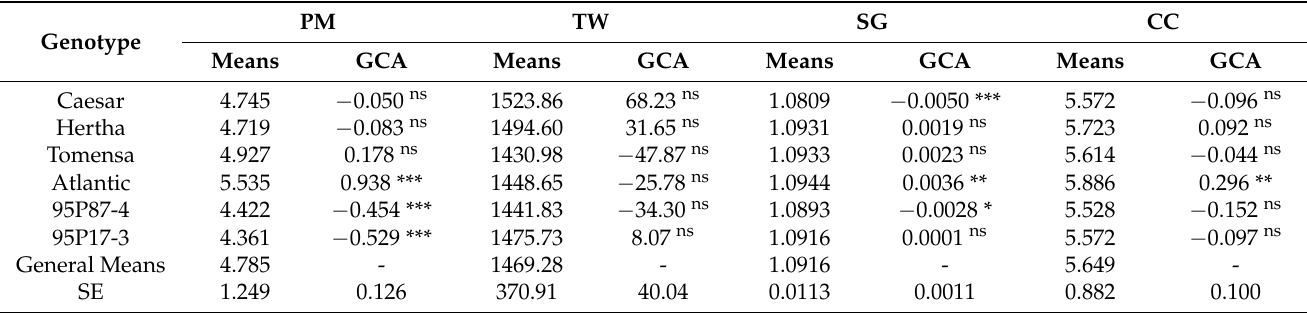
Table 8. Mean values and estimates of GCA effects and its standard errors of six parental genotypes across three sites for agronomic and quality